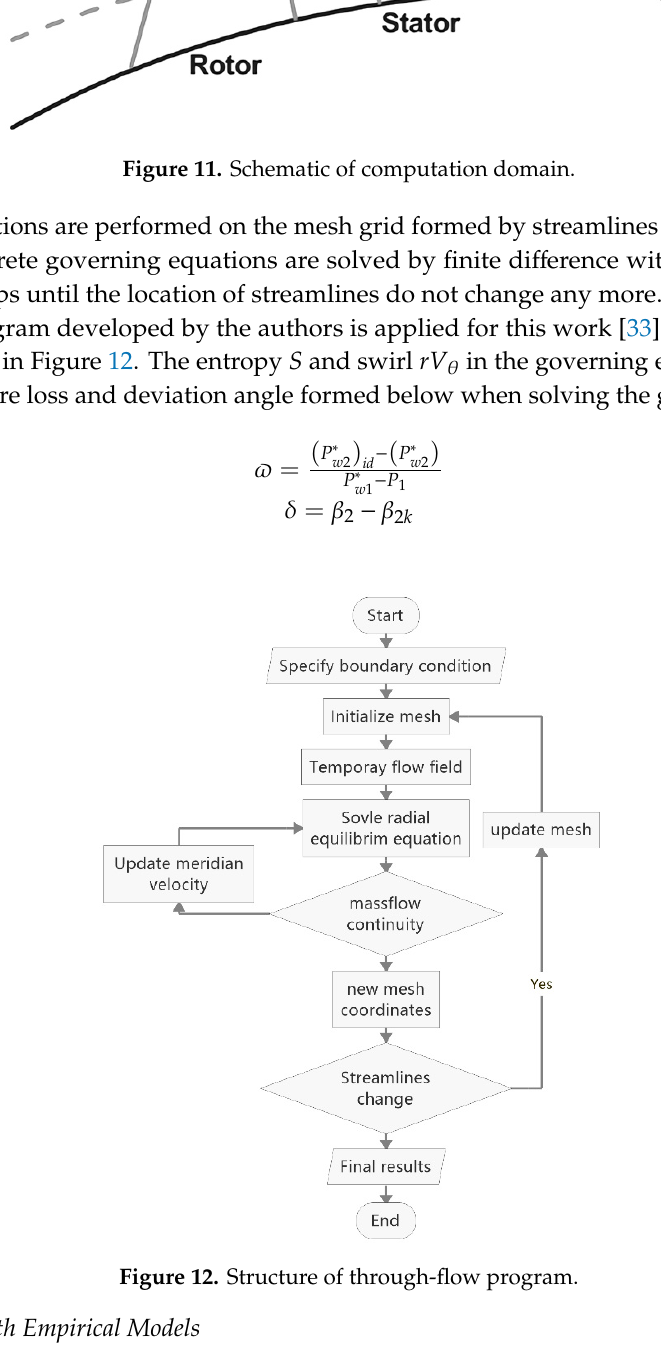
Figure 13. Computation grids for the two-stage transonic compressor. Figure 14 shows the overall performance maps of total pressure ratio (Figure 14a) and adiabatic efficiency (Figure 14b) computed by different types of models for the five rotational speed schemes. The experimental characteristic lines are also plotted for reference. SVR, GPR, EMP, and EXP represent SVR models, GPR models, empirical correlations and experimental data, respectively. In